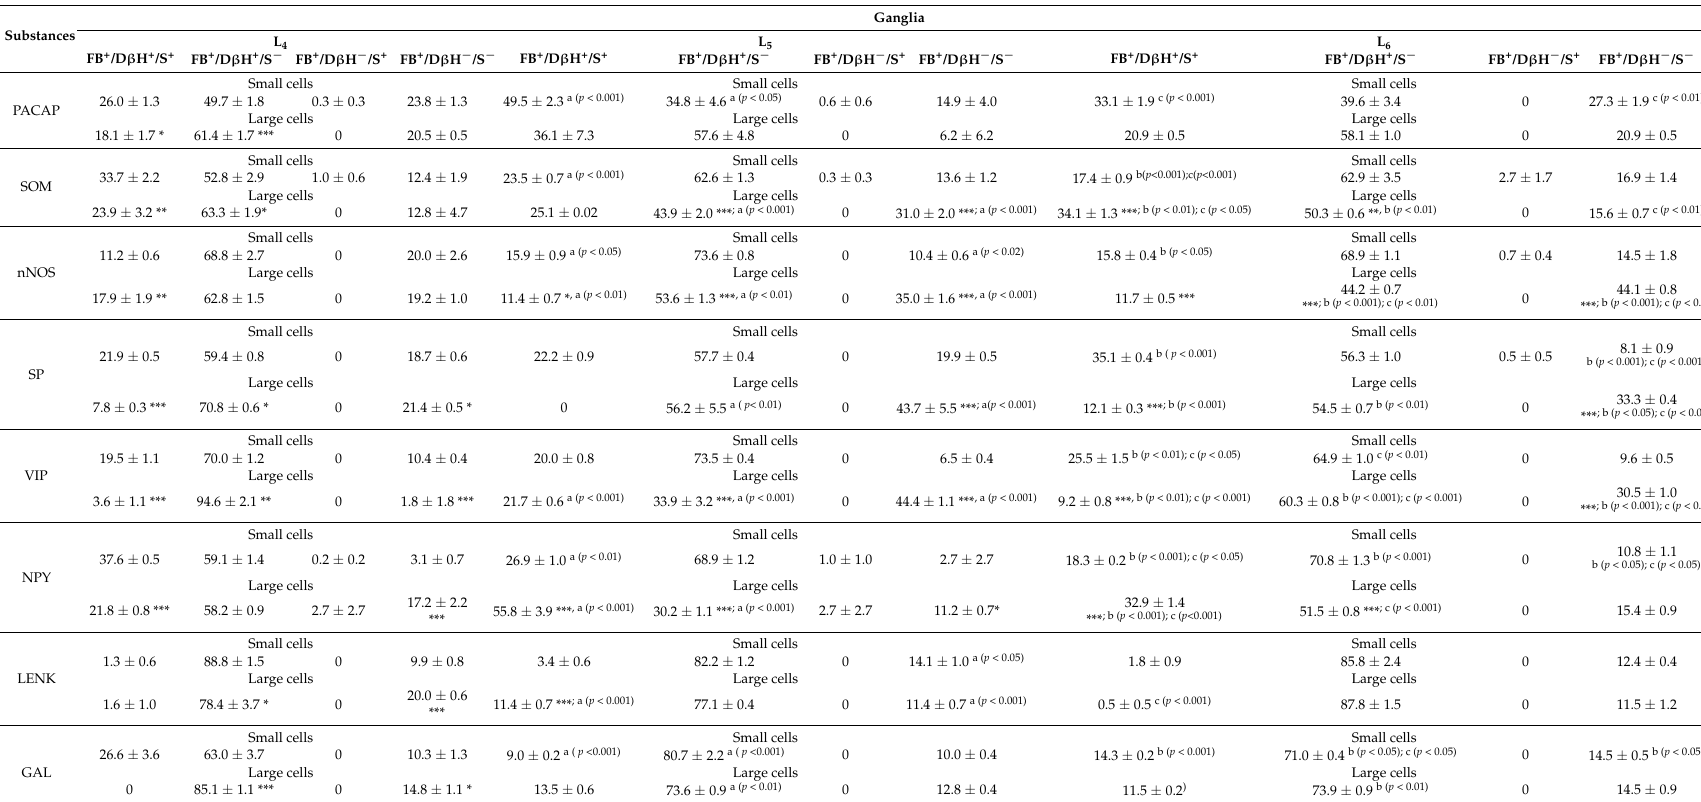
Table 1. Percentages of retrogradely labeled small- and large-sized neurons in the porcine lumbar (L 4 –L 6 ) sympathetic chine ganglia projecting to the skin of the